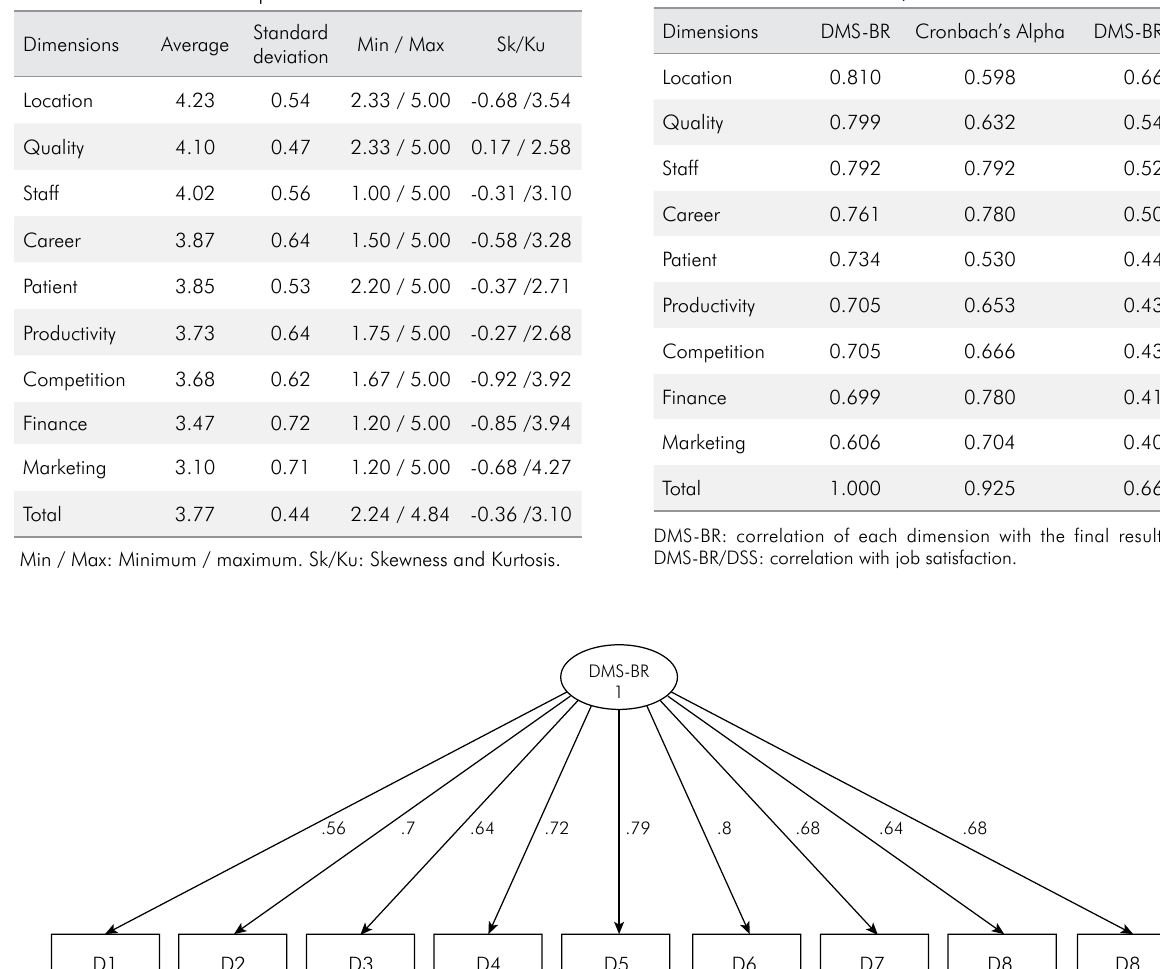
Table 3. DMS-BR: descriptive measures. Table 4. DMS-BR: Validity.